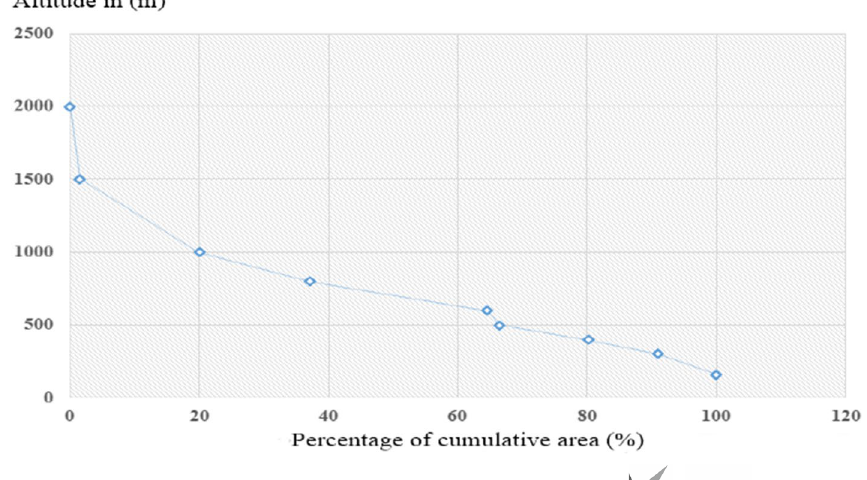
Fig. 2 Hypsometric curve of the Inaouene